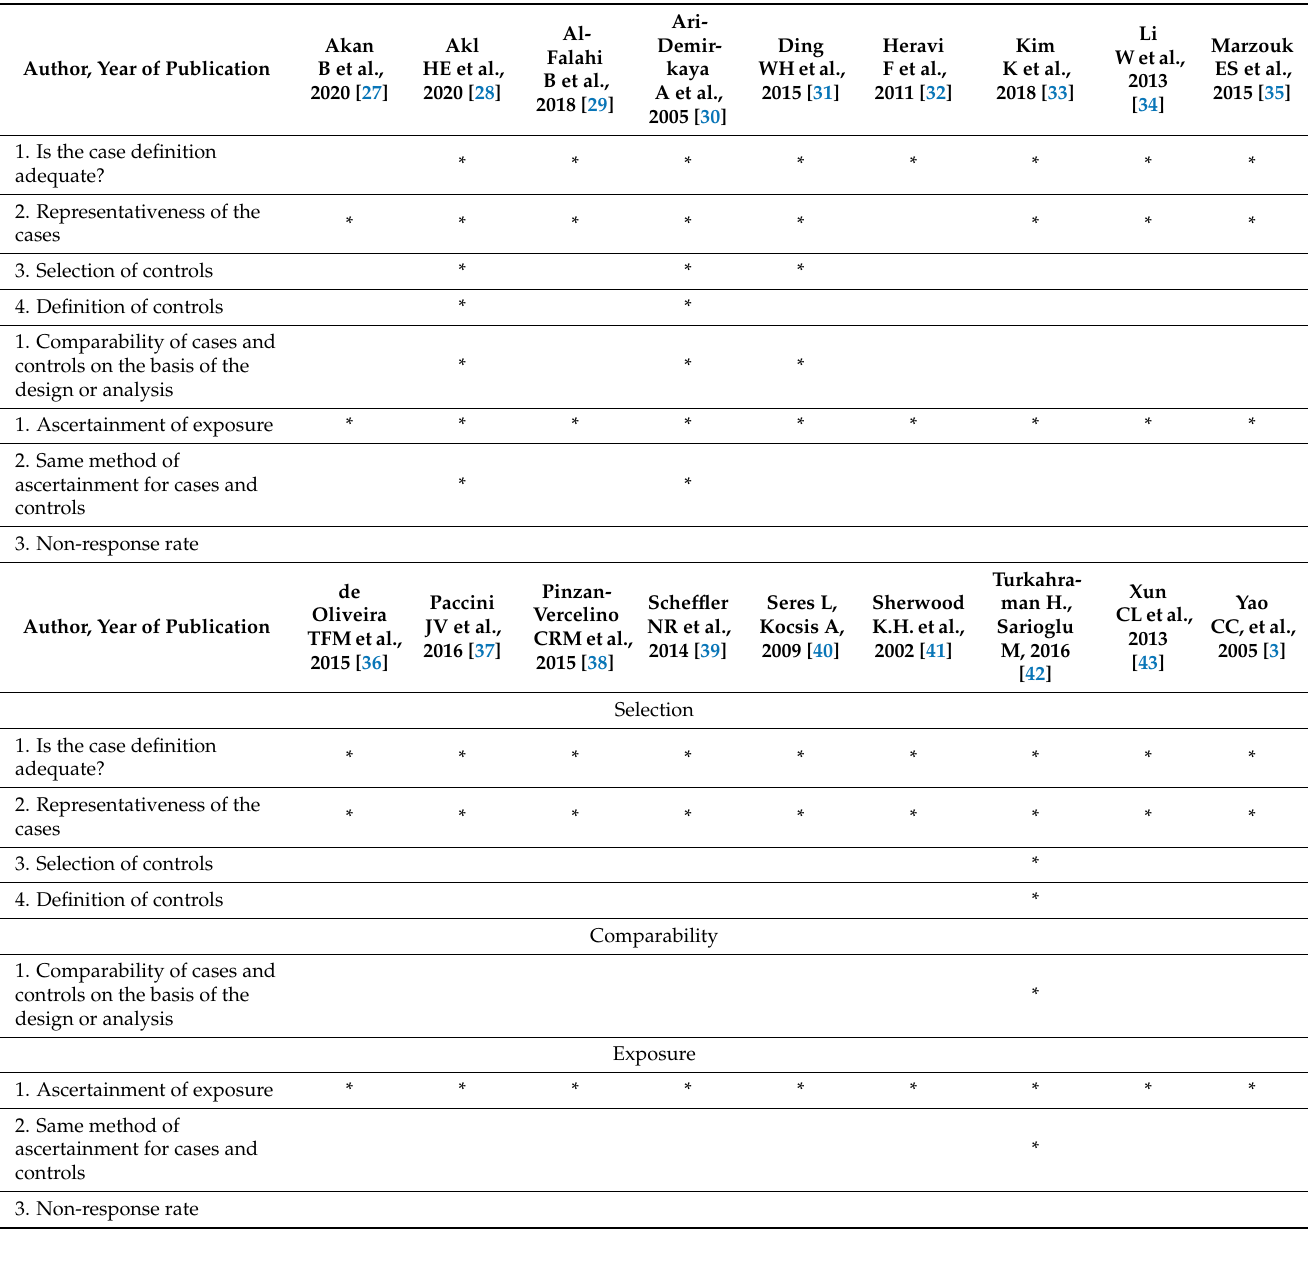
Table 2. The Newcastle–Ottawa Quality Assessment Scale for case-control studies. *-fulfilled